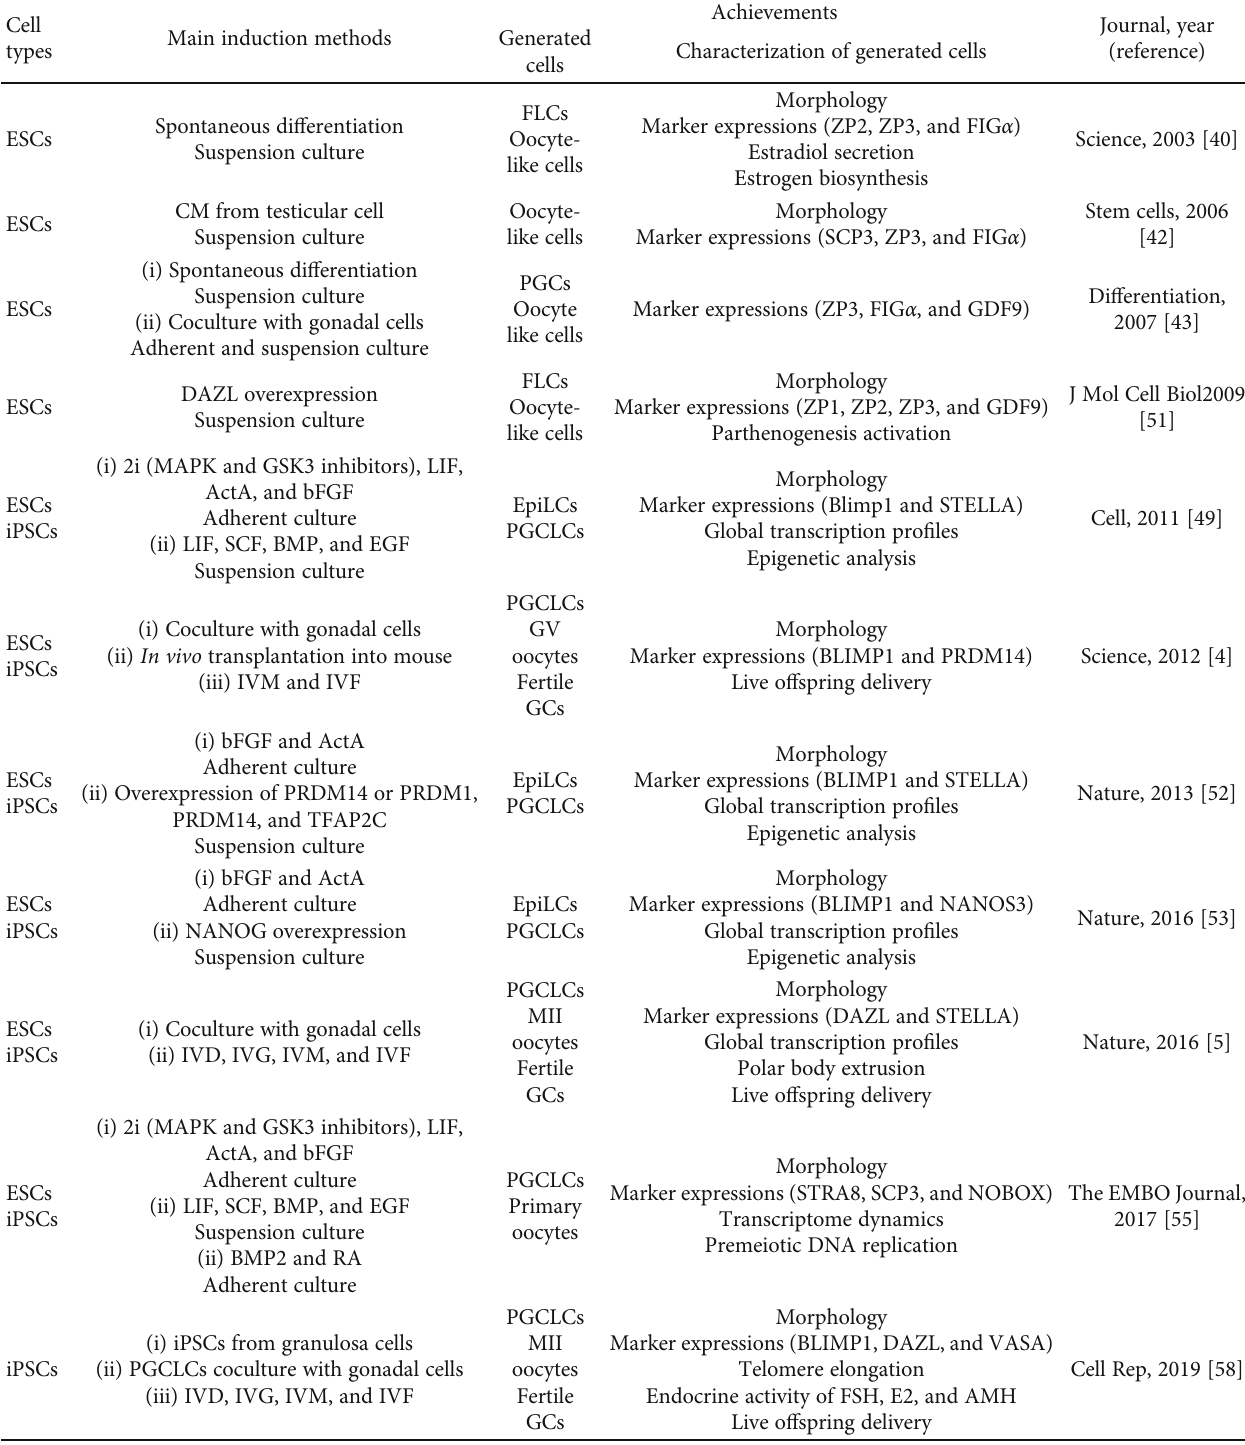
Table 1: Mouse female GCs di ff erentiation from PSCs in vitro